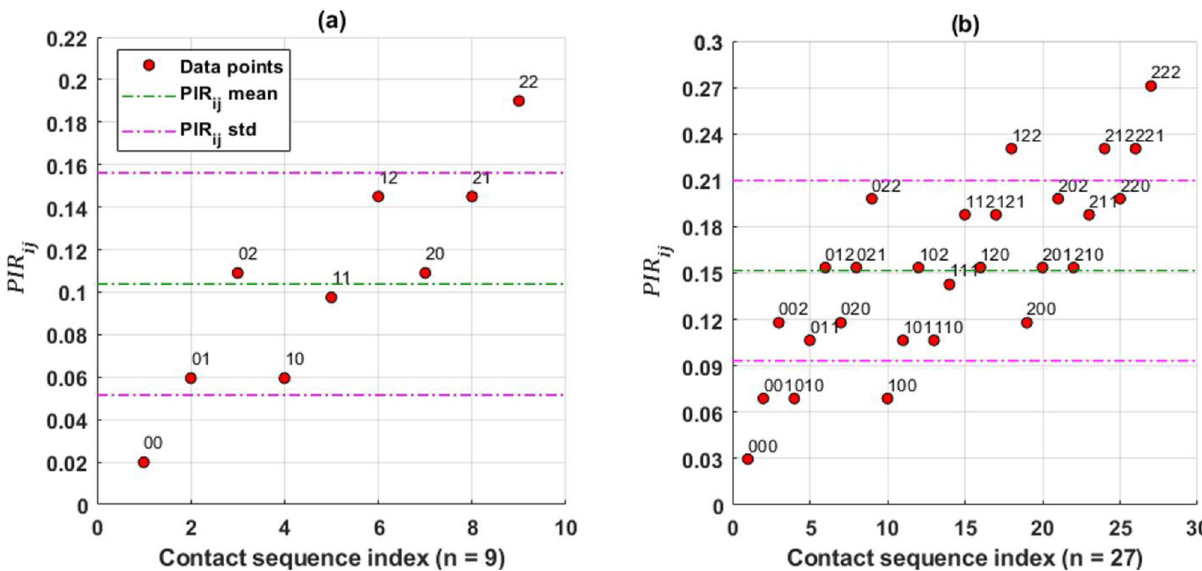
Fig 2. Sensitivity analysis of the impact of probability of viral transmission and the number of close contacts on PIR ð t 1 : t 2 Þ . We estimated values of i ; j : P = 0.01, P = 0.05, P = 0.1. Panel (a): the estimated PIR ð t 1 : t 2 Þ for | C ( � ) | = 2, i.e., PIR ð t 1 : t 2 Þ i ; j for the synthesized data with three levels of p ð�Þ low medium high i ; j X ð m Þ ; k ð m Þ! j two close contacts; therefore, there are n = 3 2 = 9 possible contact sequences with different combinations of p ð�Þ levels, and those combinations are X ð m Þ ; k ð m Þ! j , where X 1 , X 2 , ... , X 2 {0,1,2}, which corresponds to low, medium, and high levels of p ð�Þ . The mean level of encoded in the form X 1 X 2 ... X n n X ð m Þ ; k ð m Þ! j PIR ð t 1 : t 2 Þ i ; j (green dash-dotted line) associated with its standard deviation indicated by purple dash-dotted lines are also plotted. Panel (b): the results for | C ( � ) | = 3 with n = 3 3 = 27 possible contact